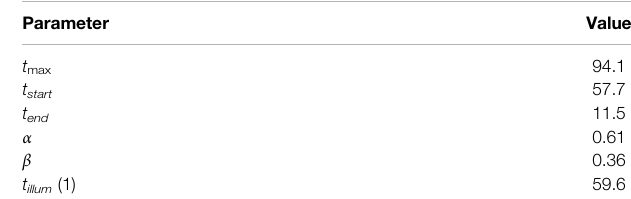
TABLE 2 | Parameters of the optimized 4-oscillator